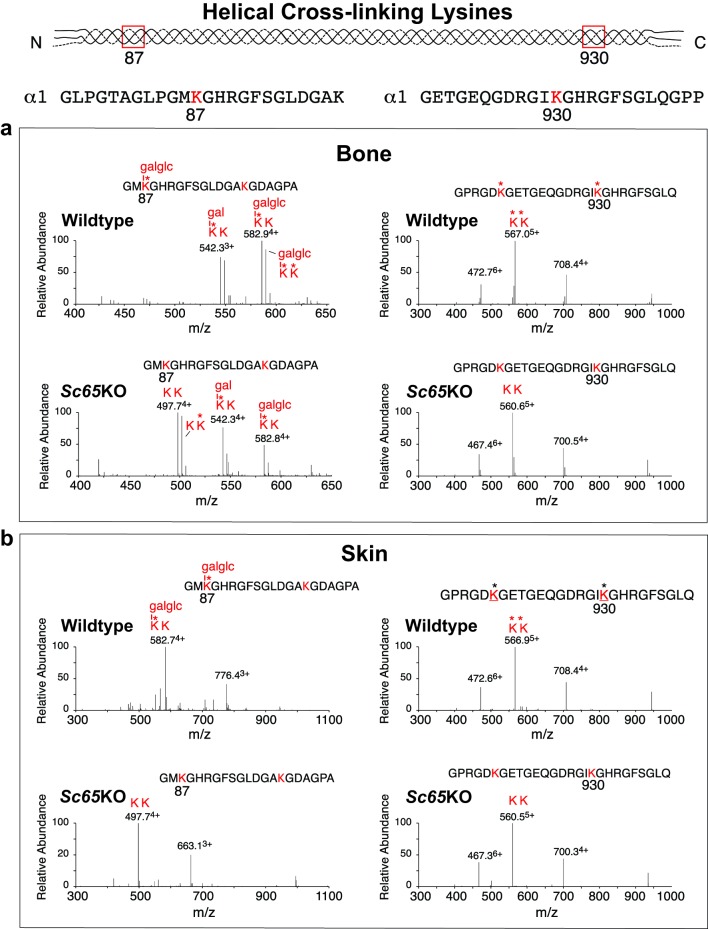
Undermodification of lysine residues at cross-linking sites in Sc65-null skin and bone collagens revealed by tandem mass spectrometry.Peptides from the two helical domain cross-linking sites in collagen α1(I) prepared by bacterial collagenase digestion of decalcified bone (a) and skin (b) were identified by LC-MS. Their post-translational profiles are compared between Sc65KO and wild type. a) Spectra from the two helical sites (Lys-87 and Lys-930) in bone show that Lys-87 is essentially all glcgalHyl plus galHyl in wild type and about 40% is lysine plus hydroxylysine in mutant; Lys-930 is all hydroxylysine in wild type and all lysine in mutant. b) Spectra from the two helical sites (Lys-87 and Lys-930) in skin show that Lys-87 is all glcgalHyl in wild type and all lysine plus hydroxylysine in mutant; Lys-930 is all hydroxylysine in wild type and all lysine in mutant. (glcgal = glucosyl-galactosyl; gal = galactosyl; * = hydroxyl group).